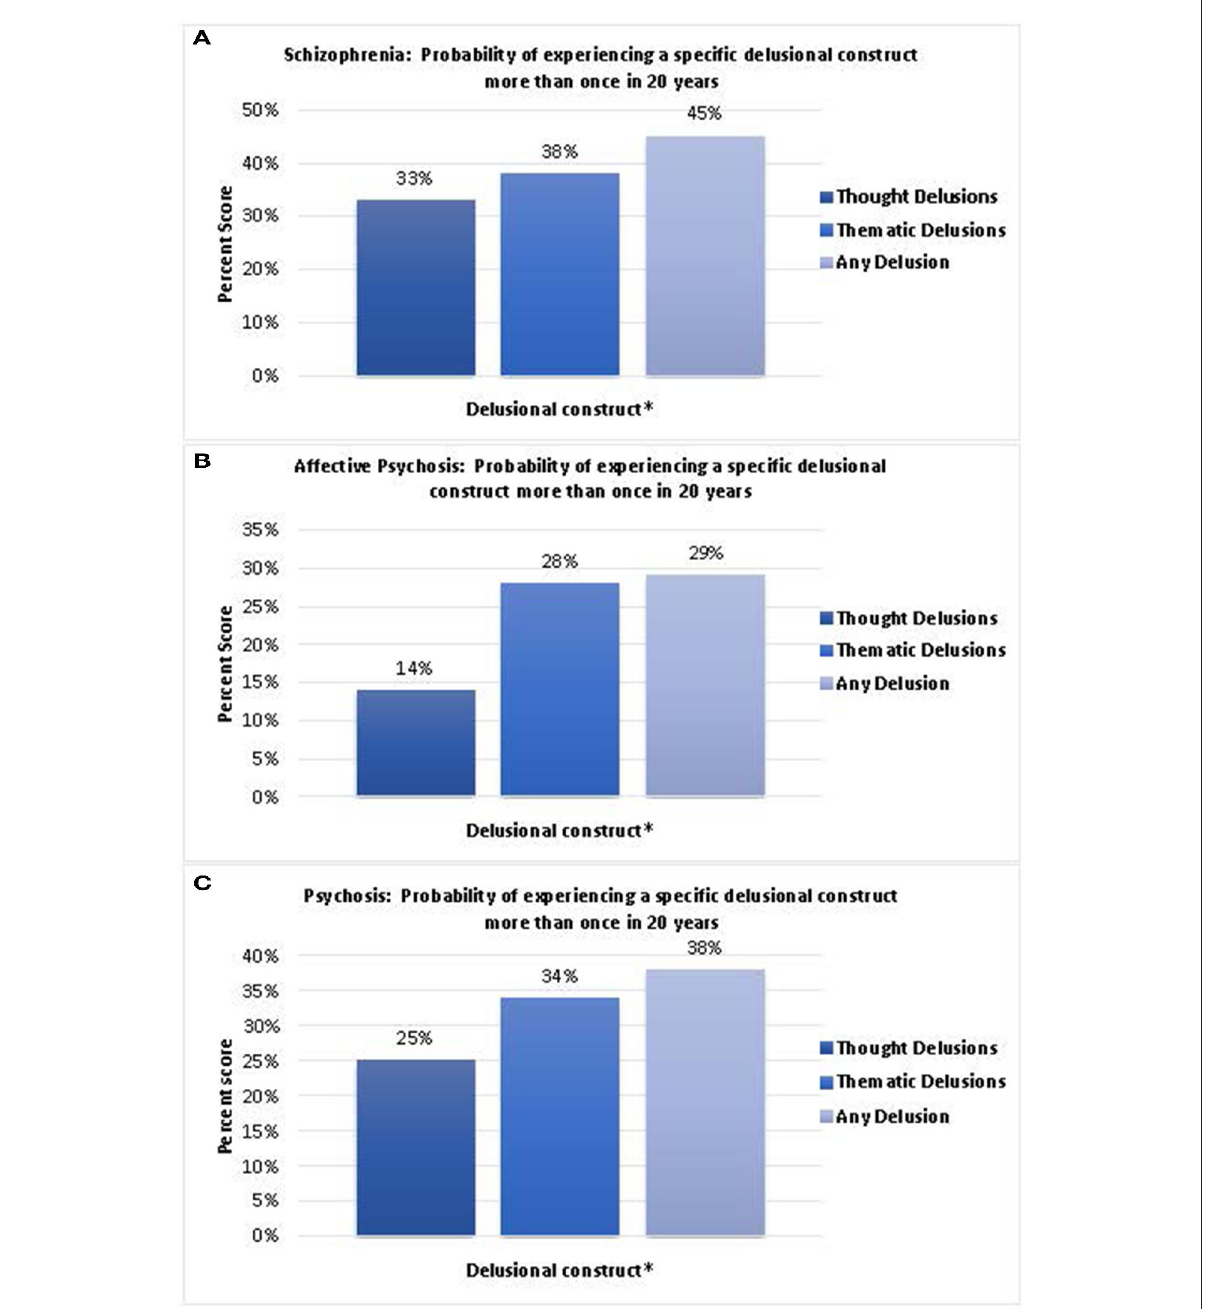
FIGURE2 (A) Probability of experiencing a specific delusional construct in individuals with schizophrenia more than once in 20 years. (B) Probability of experiencing a specific delusional construct in individuals with affective psychosis more than once in 20 years. (C) Probability of experiencing a specific delusional construct in individuals with psychosis more than once in 20 years. ( ** Delusional construct: Thought delusion: Thought insertion; Thought withdrawal; Thought broadcast; Thought dissemination; Referential; “Made” feelings; “Made” impulse; “Made” volition. Thematic delusion: Somatic; Persecutory; Self-deprecation; Nihilistic; Grandeur; Religious; Fantastic;